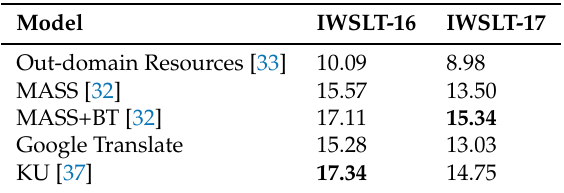
Table 2. Performance comparison of existing studies on Korean–English neural machine translation (NMT) models.